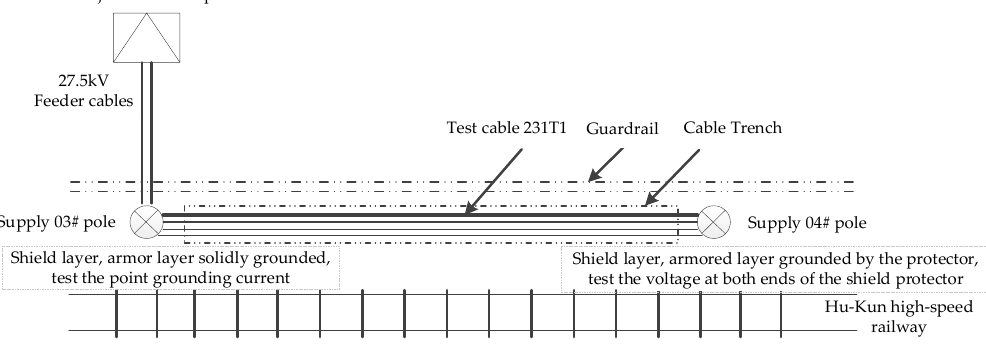
Figure 8. “Hukun 2” 27.5 kV feeder cable double-end grounding test structure.